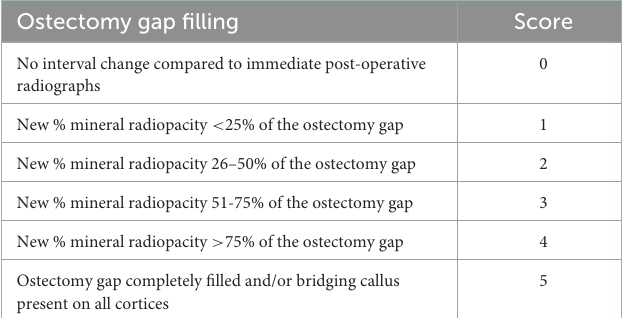
TABLE 1 Radiographic scoring